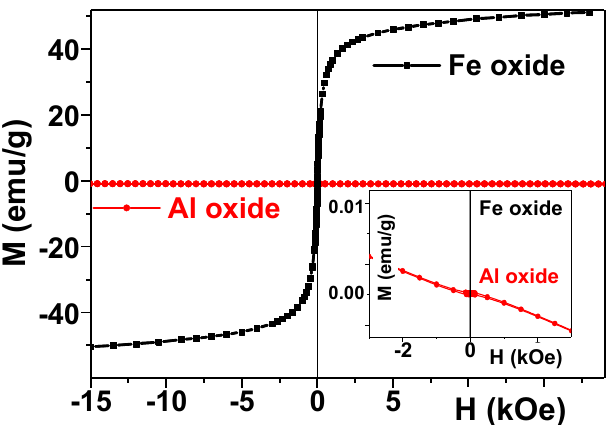
Figure 3. Magnetic hysteresis loops of Fe 2 O 3 and Al 2 O 3 LTE as-prepared nanoparticles. Inset shows the same responses in low magnetization scale.